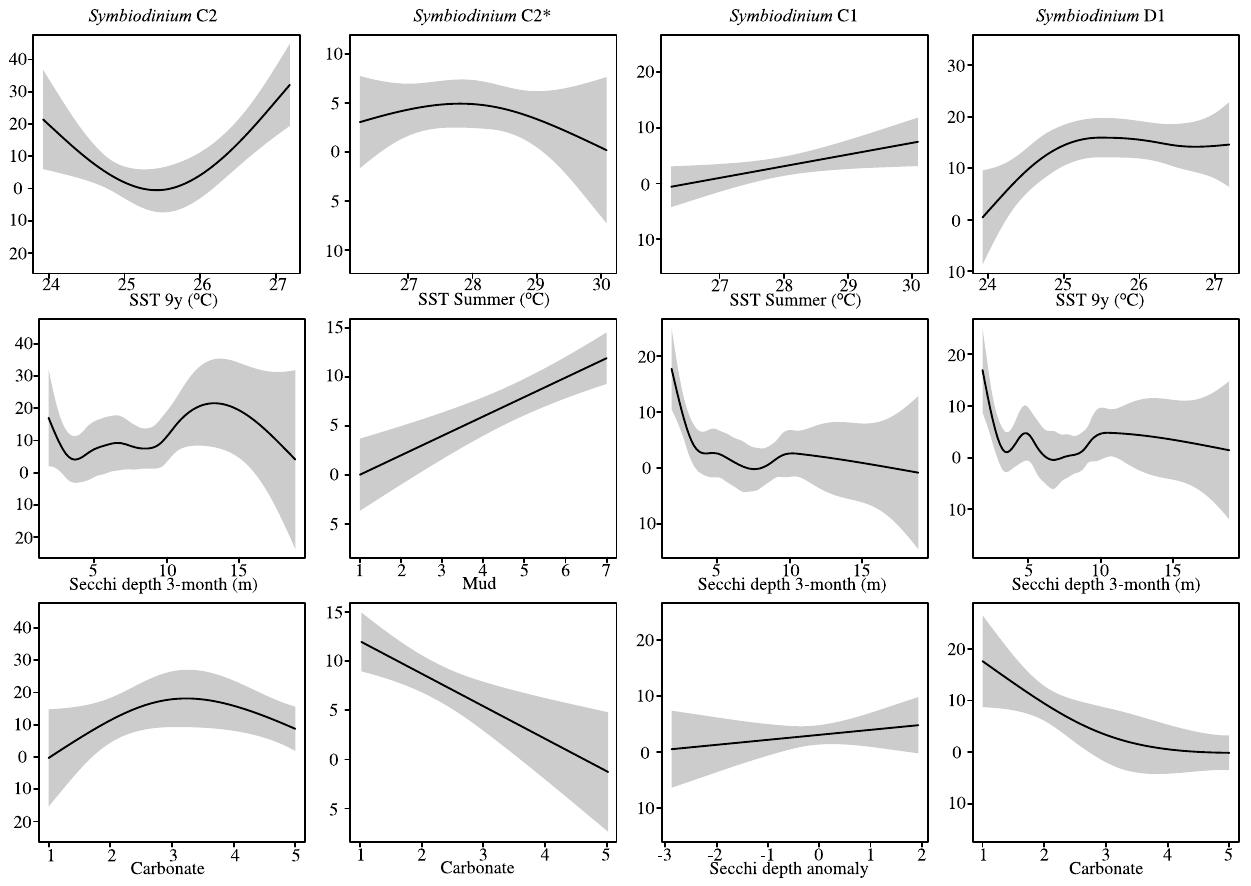
Figure 4. Partial plots of the GAMs of dominant Symbiodinium types along gradients of long-term SST (9-year), SST summer mean, 3-month Secchi depth, anomalies in Secchi depth, mud and carbonate content of sediments on the Great Barrier Reef. Solid line shows the model and grey area is the 95% confidence interval. Y-axis is scaled to abundance, values around zero indicate absent symbiont type, negative units are included as they represent the range of confidence limit boundaries.